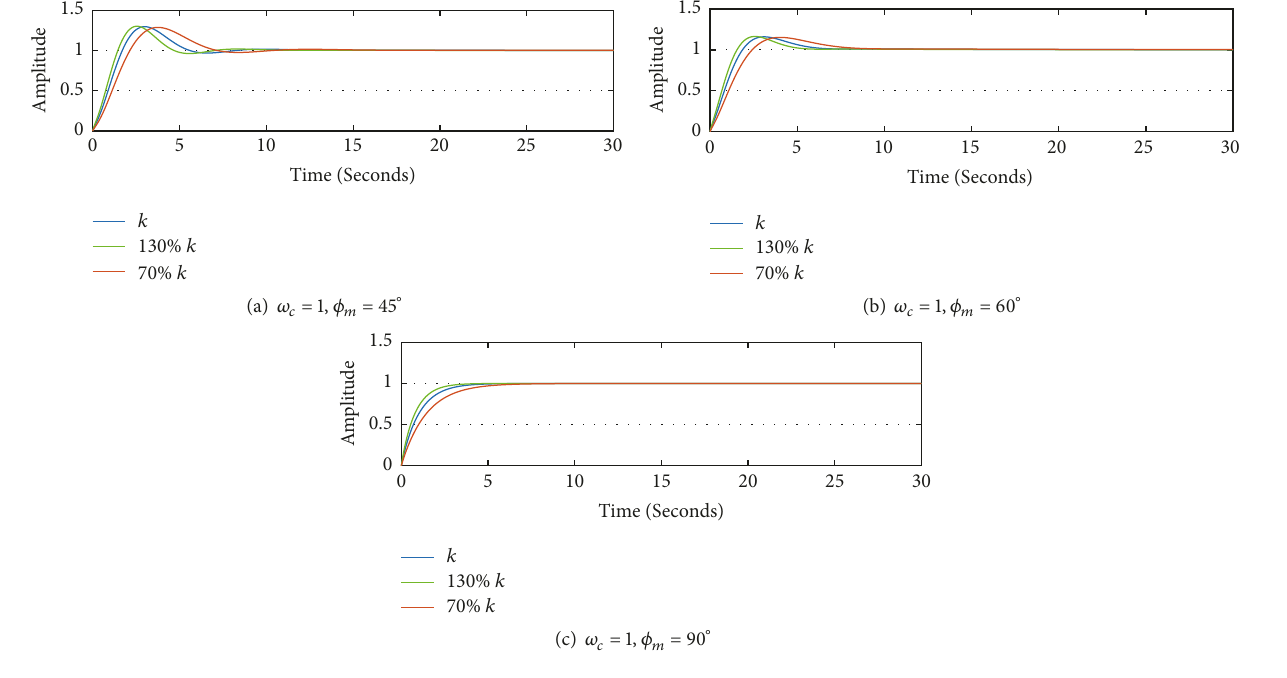
Figure 13: Step responses of 𝑃 1 (𝑠) with different 𝜙 𝑚 .